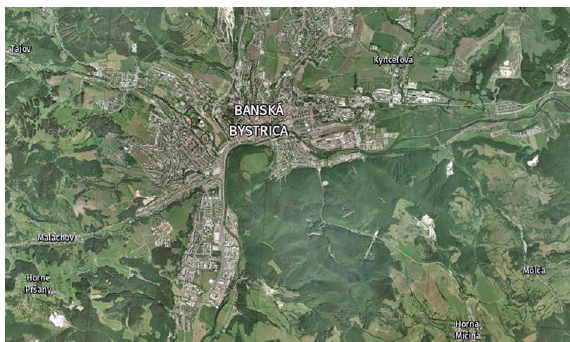
Fig. 4. Example of labels above the